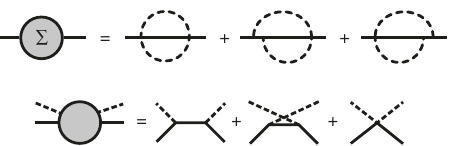
Fig. 8 Diagrams beyond this work. The top panel shows some of the additional self-energy diagrams resulting from the four-point Debye − Waller vertex, which introduces a new 1e1a process interfering with the two considered in this work in the bottom